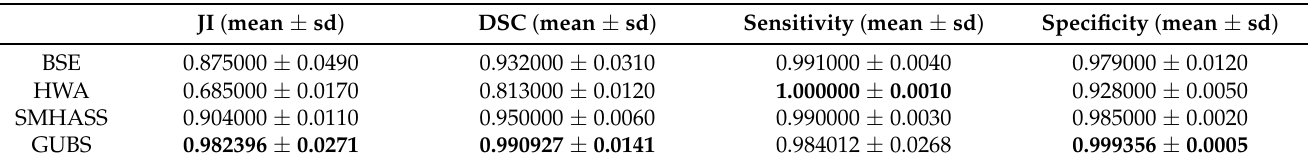
Table 2. Performance analysis of GUBS compared to BSE, HWA and SMHASS [17] methods based on the BW data by presenting the average in each measure of similarity.